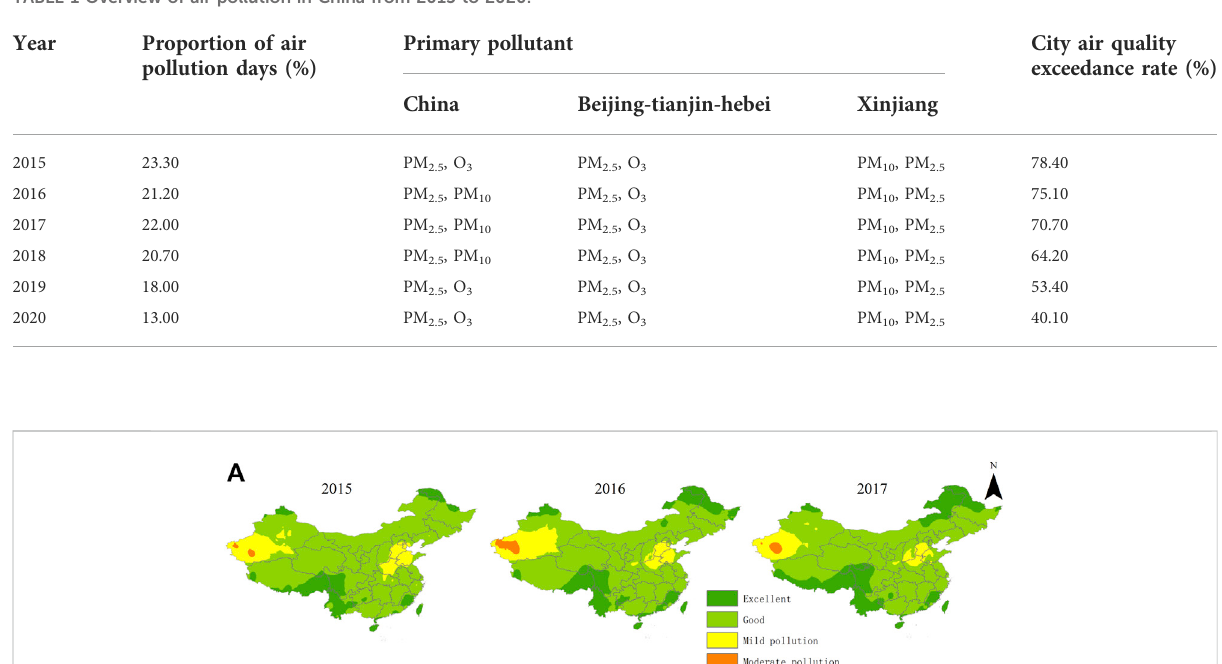
TABLE 1 Overview of air pollution in China from 2015 to